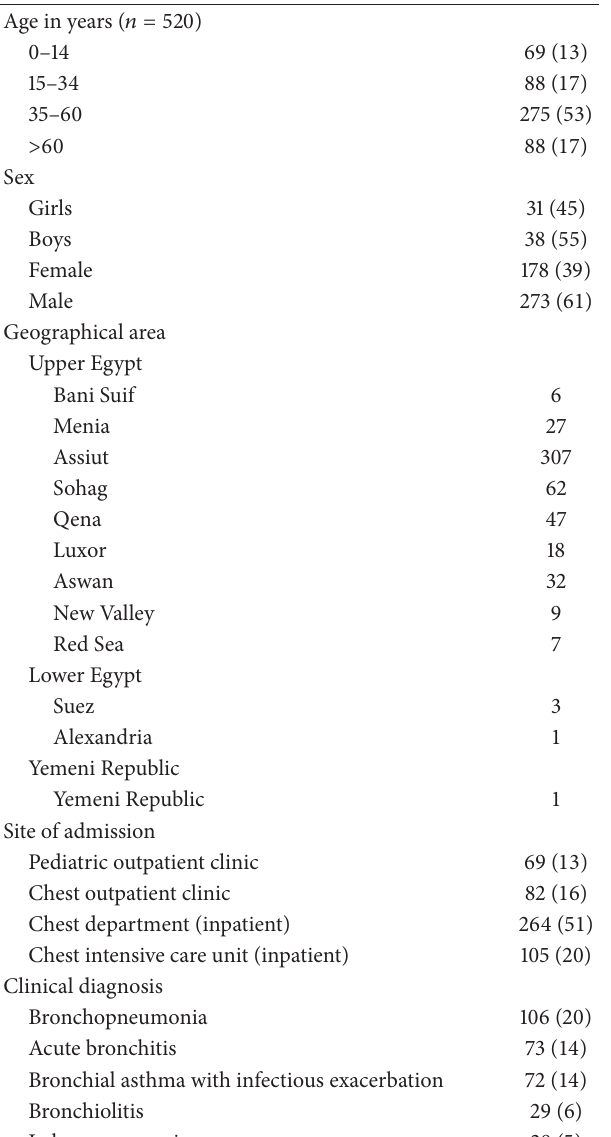
Table 1: Demographic and clinical characteristics of patients. Patients’